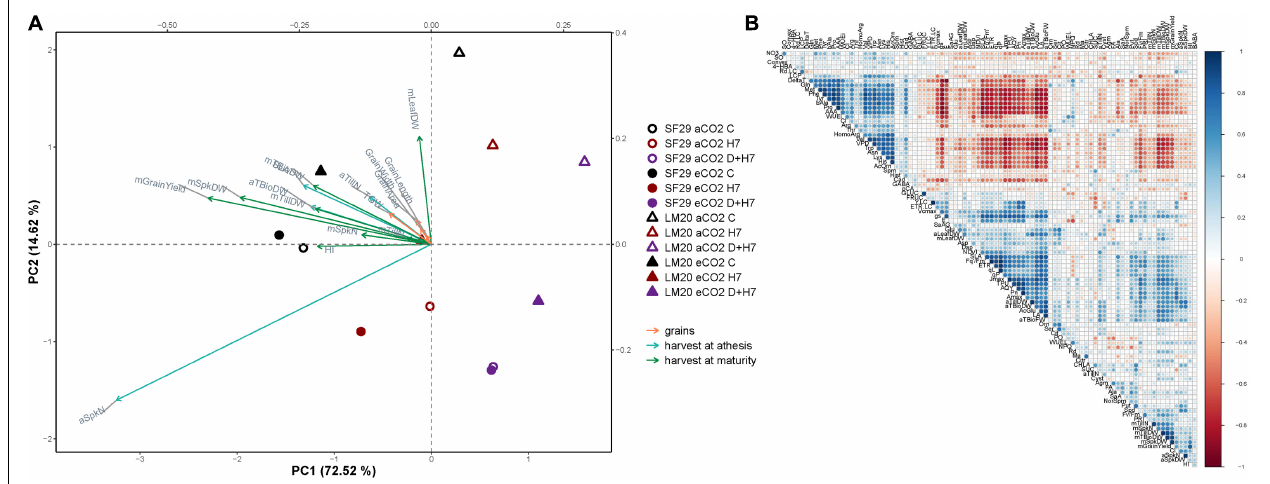
FIGURE 7 | Multivariate statistical analyses of yield-related parameters. (A) Principal component (PC) analysis of the changes in yield-related parameters represented grain yield, the harvest at the anthesis and the ripening stage in orange, blue, and green arrows, respectively, and (B) correlation matrix between the metabolites and physiological and yield-related parameters, in which the size and intensity of blue (positive) and red (negative) circles correlated with the Pearson’s square-R correlation number in heat-sensitive (SF29) and heat-tolerant (LM20) genotypes grown under control conditions (C), heat stress at Day 7 (H7) and combined heat stress and drought at Day 7 (D + H7) at ambient CO 2 (aCO 2 ) or elevated CO 2 (eCO 2 ). The X -axis and Y -axis represent the PC1 and PC2, respectively, with the percentage of the total variance of the